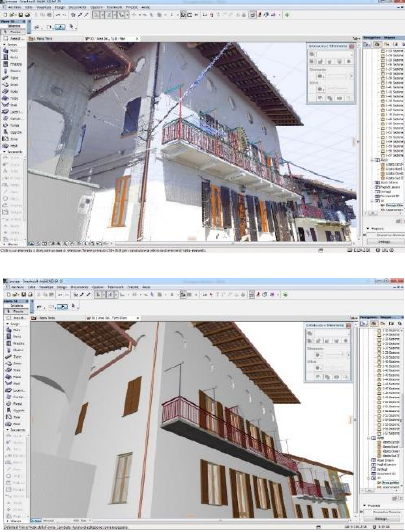
Figure 19. Modelling phases: from point clouds to HBIM